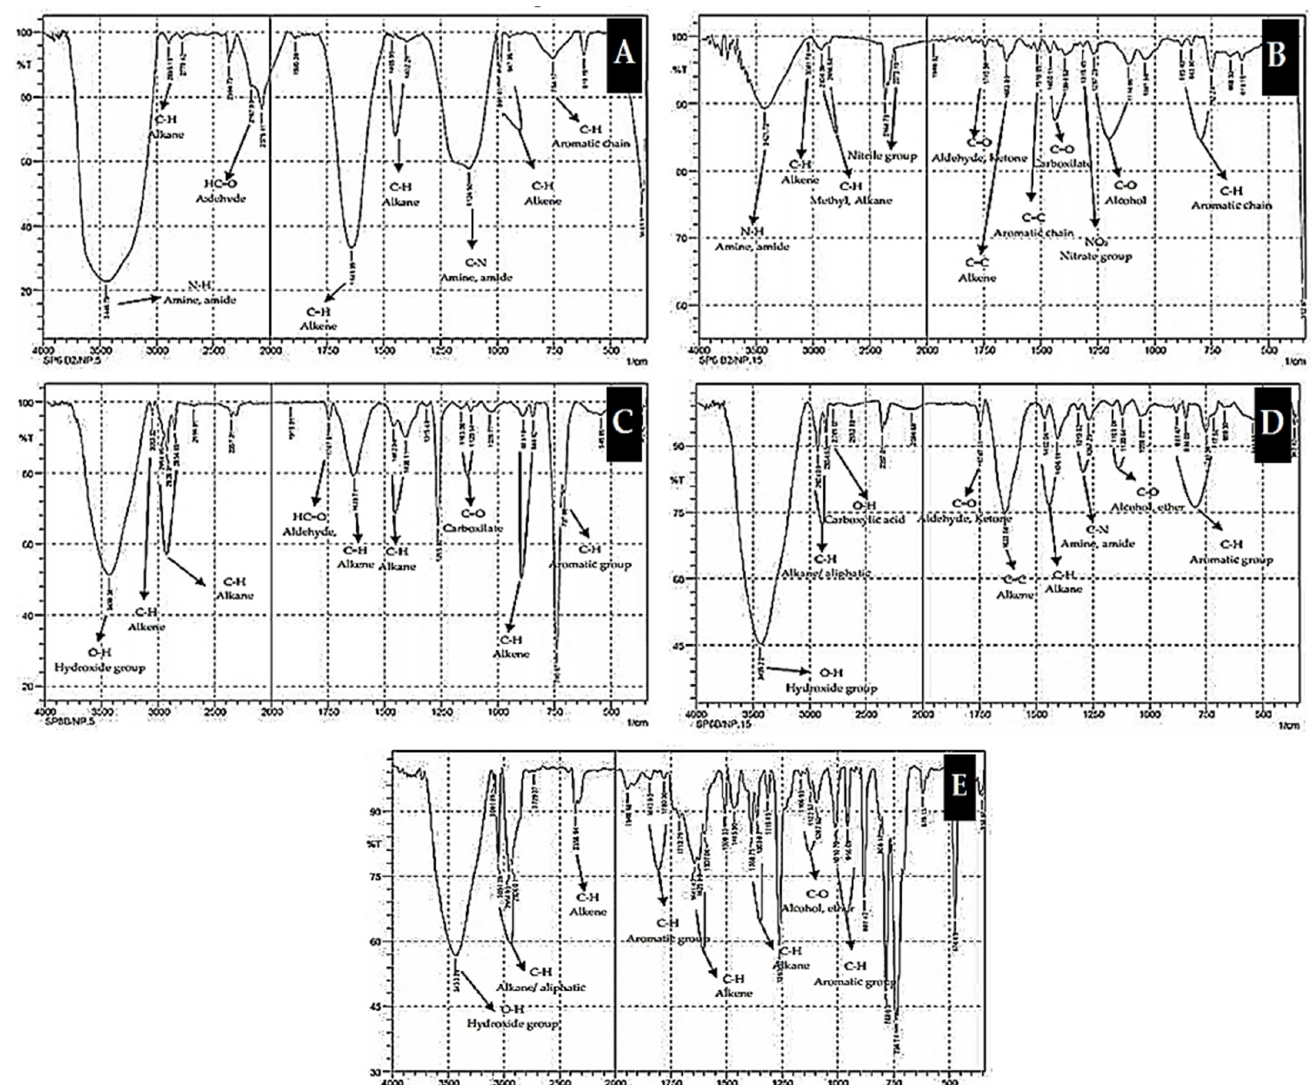
Figure 5. FTIR spectra displaying the functional groups of biodegradation products as a function of the interaction time: ( A ) 5 days of interaction, ( B ) 10 days of interaction, ( C ) 15 days of interaction, ( D ) 20 days of interaction, and ( E ) 25 days of interaction.